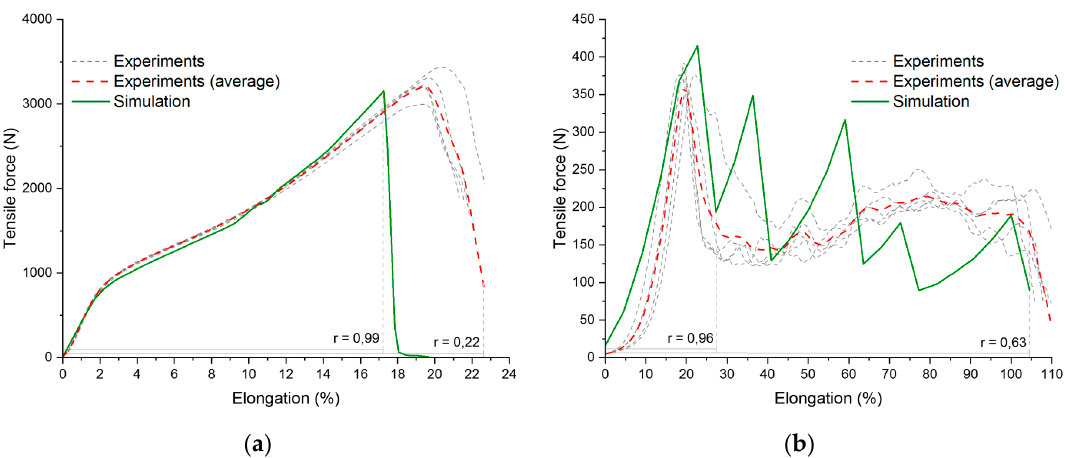
Figure 12. Comparison of experimental and simulation results for welded membrane tests: ( a ) Shear load and ( b ) peeling load (with correlation coefficient r)